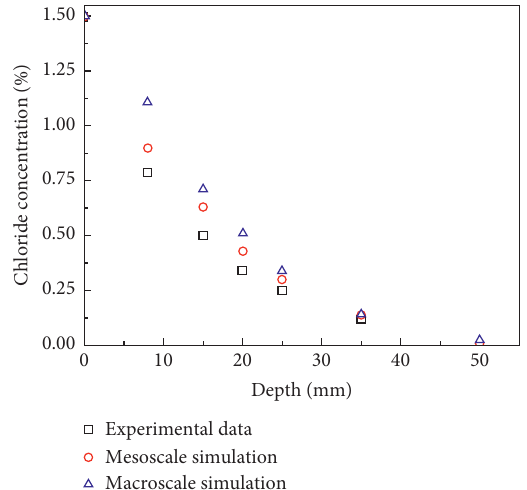
Figure 4: Comparison of the experimental data and simulated results.